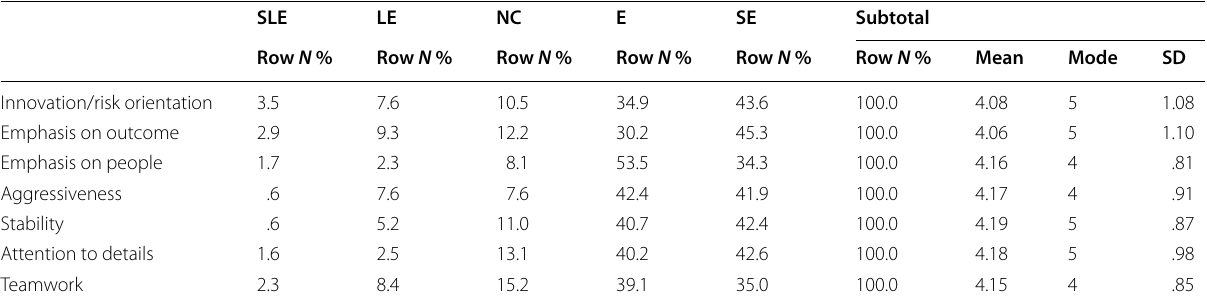
Table 2 Statistics of firm culture emphasized by manufacturing companies in Nigeria during 2011